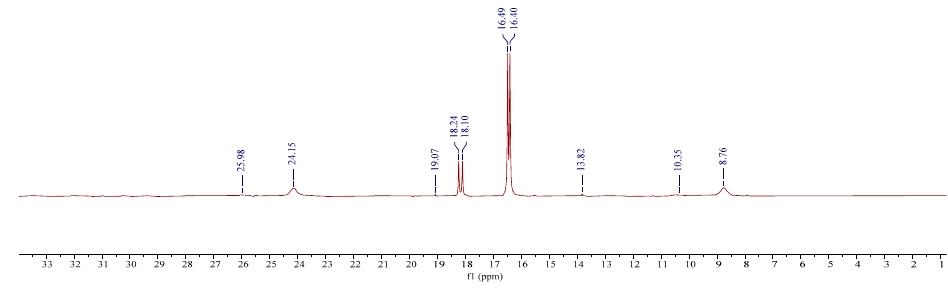
Figure 3. 195 Pt NMR spectrum of complex 5 in DMSO- d 6 at room temperature, after 10 days in solution.